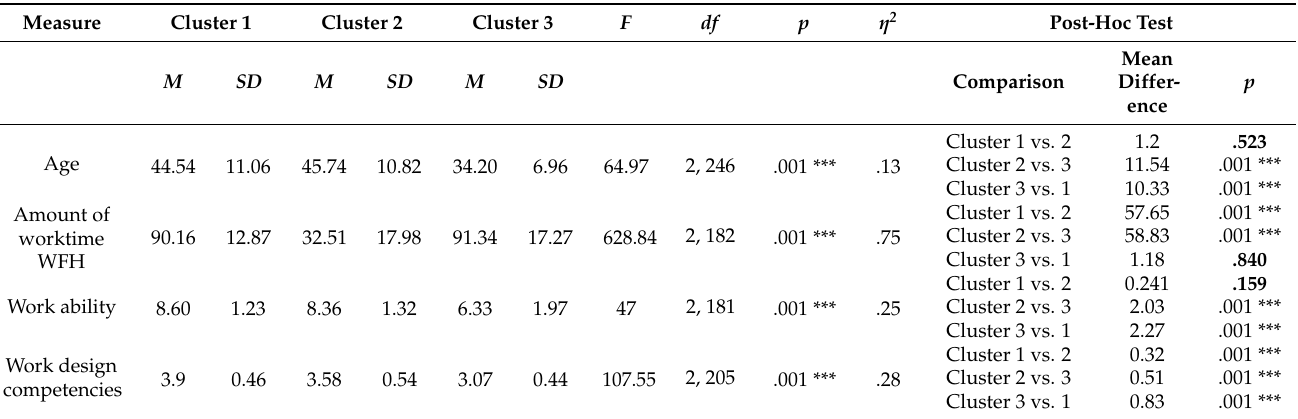
Table 6. Descriptive statistics of the test variables divided into clusters ( N = 497), analyses of variance, and post-hoc